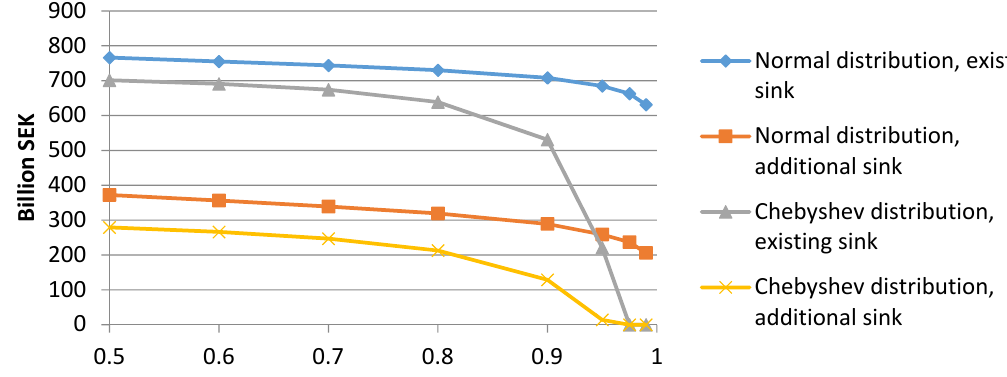
Figure 4. Value of forest pollutant sink for reaching the EU 2050 climate and BSAP nutrient targets under different probabilities of reaching the targets and assumptions of probability